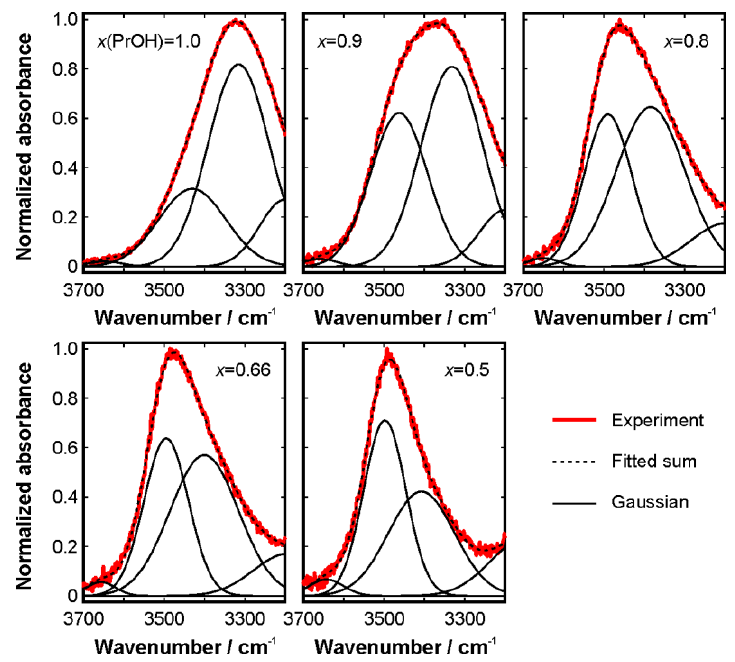
Figure 5. Decomposed FTIR spectra in the OH stretching region for five selected mixtures.